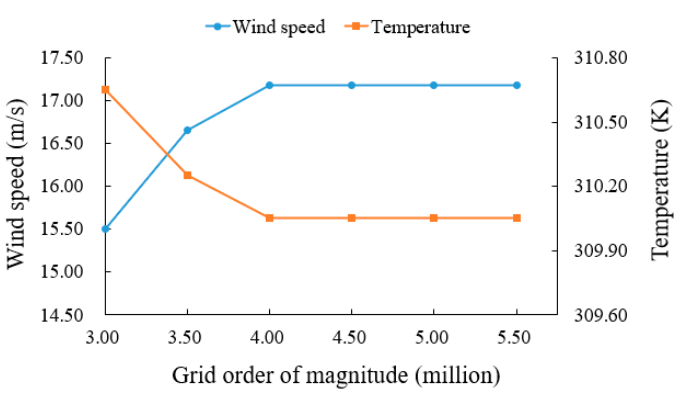
Figure 7. Grid independence verification results.